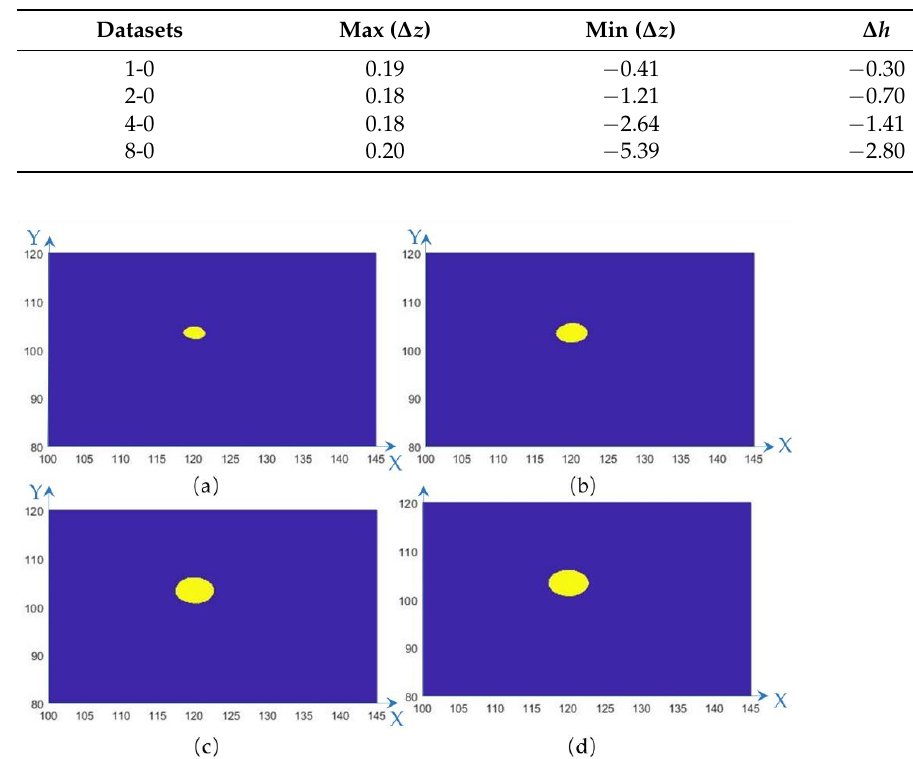
Table 2. The threshold values for different subsidence datasets (cm).